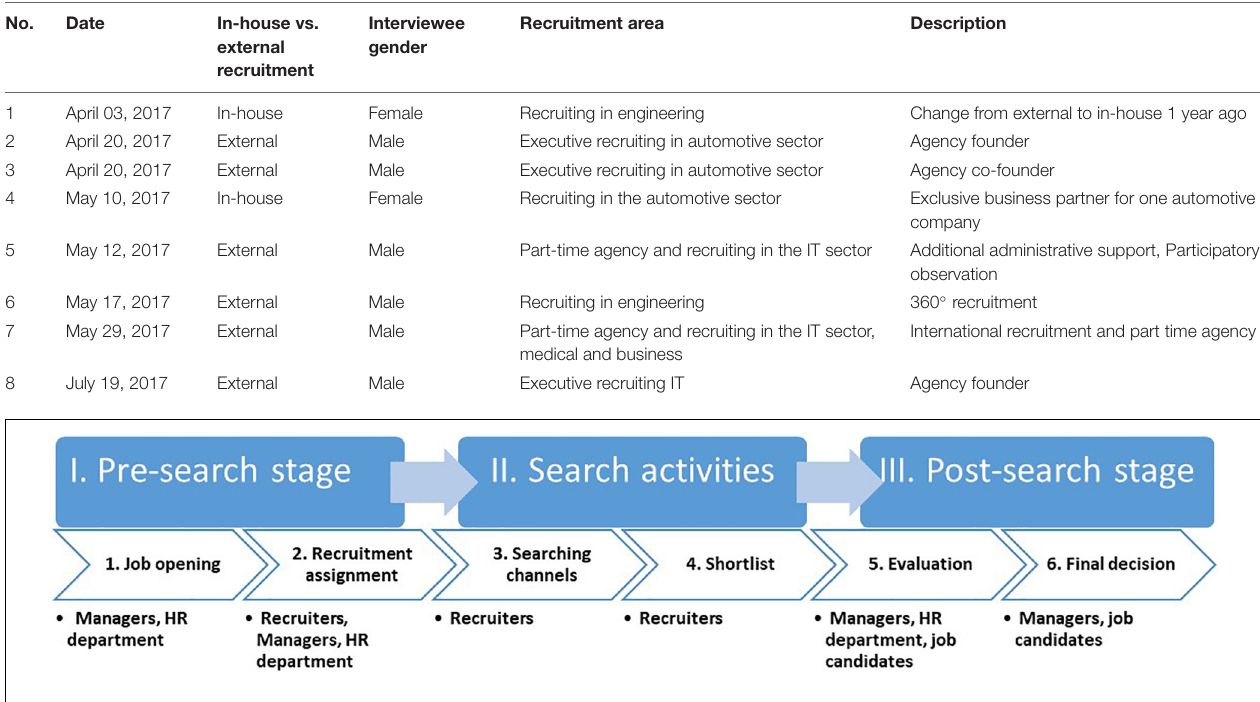
FIGURE 1 | A model of the modern recruitment process. Three stages are represented in the upper boxes in white typeface. Six recruitment steps are represented in the arrows (second line) in black typeface. The main actors are listed with dots under each